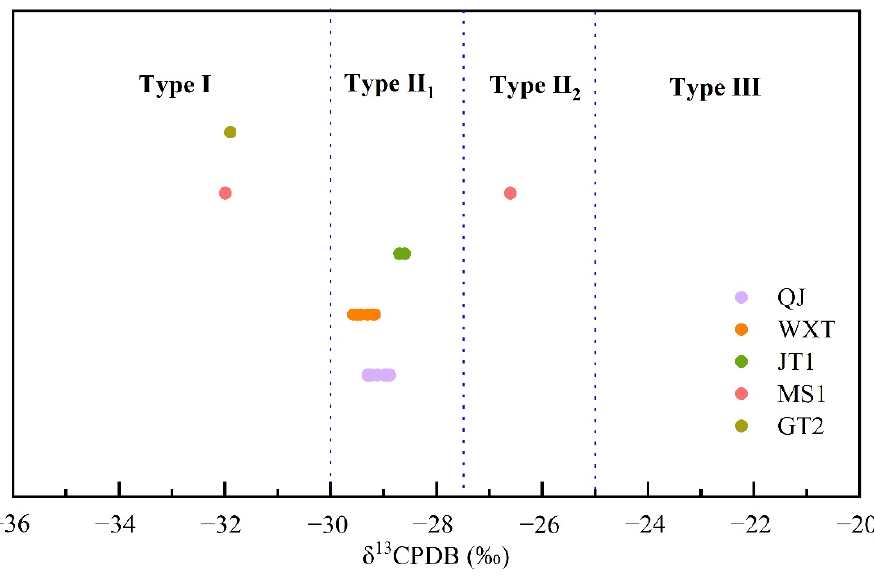
Figure 7. Kerogen types of source rocks in the Meitan Formation (Kerogen type classification is based